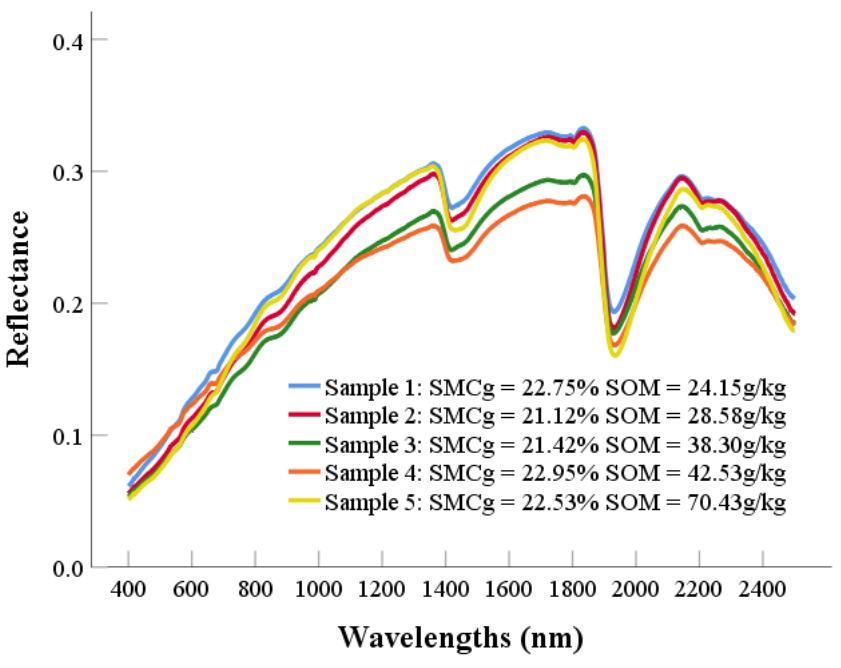
Figure 7. The soil reflectance of different samples.